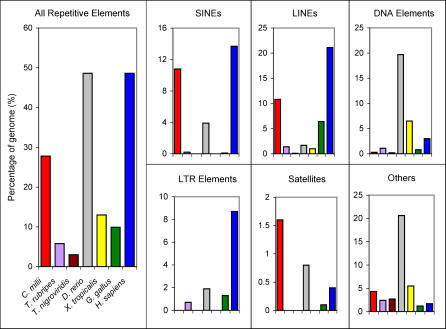
Classification of Repetitive Elements from Several Sequenced Vertebrate Genomes Using RepeatMaskerValues (% sequenced genome) for each class of repeats were obtained for Takifugu rubripes (fr1), Tetraodon nigroviridis (tetNig1), Danio rerio (danRer3), Xenopus tropicalis (xenTro1), Gallus gallus (galGal2), and Homo sapiens (hg17) from the University of California at Santa Cruz Genome Bioinformatics Site (http://www.genome.ucsc.edu). Callorhinchus milii repeats were identified in the 1.4× sequence generated in this study.